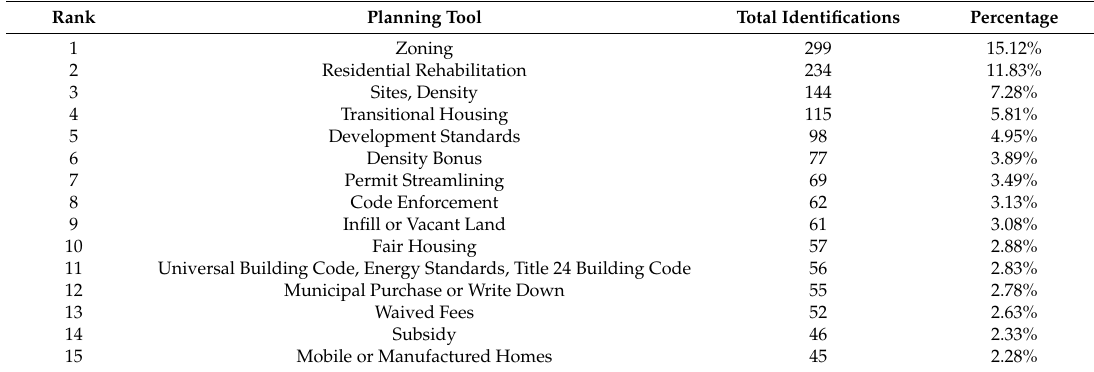
Table 5. The top fifteen planning tools ranked by total identifications. See the appendix for the complete list of 47 planning tools.